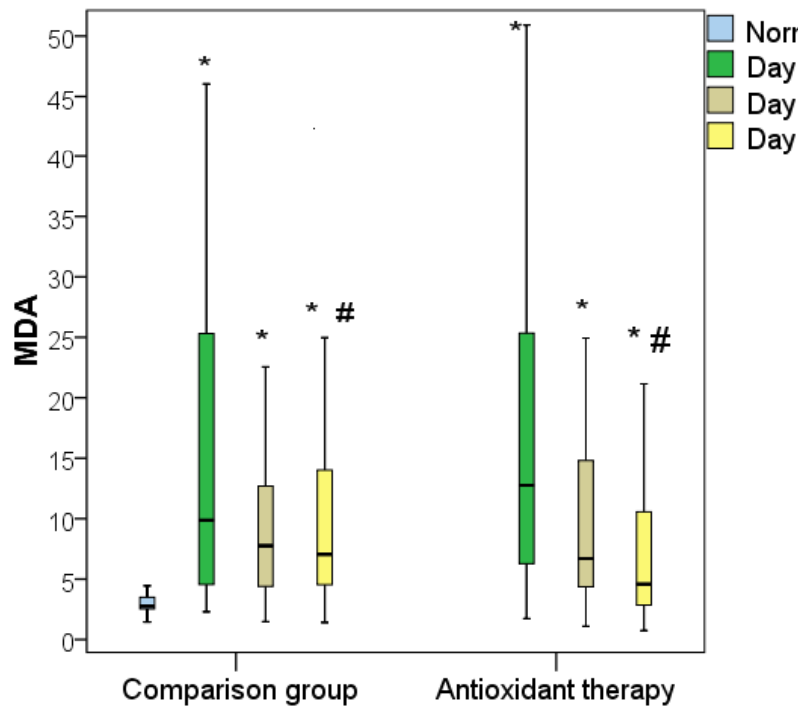
Figure 9. Dynamics of the plasma blood MDA index in obstructive jaundice in both groups (*—difference from the normal; #—difference between groups at p < 0.05, Mann–Whitney test).